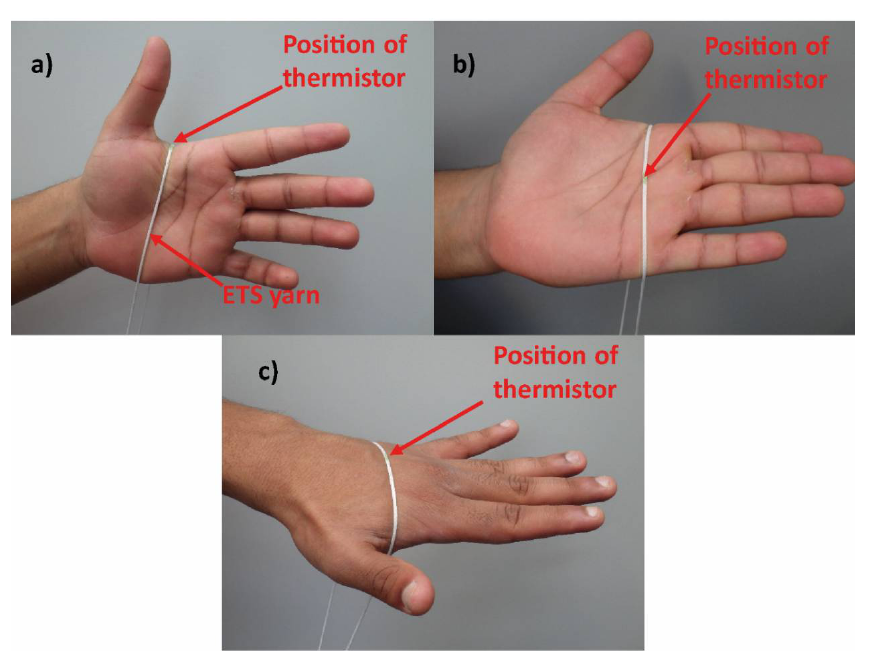
Figure 3. Positioning the temperature sensing yarn: ( a ) side, ( b ) palm, and ( c ) back of the